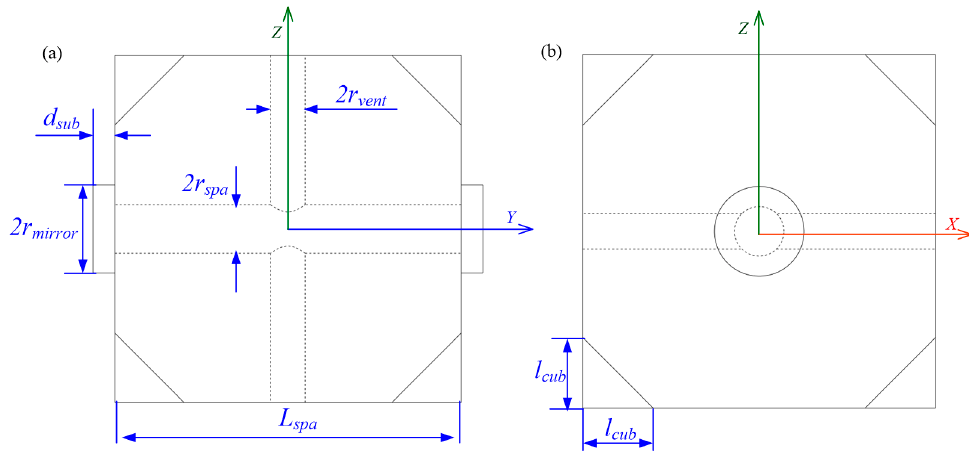
Figure 1. Sketch of the cubic optical cavity model with dimensions used for the analysis and FEA simulations in this publication. ( a ) Side view of the cubic optical cavity. ( b ) Front view of the cubic optical cavity.